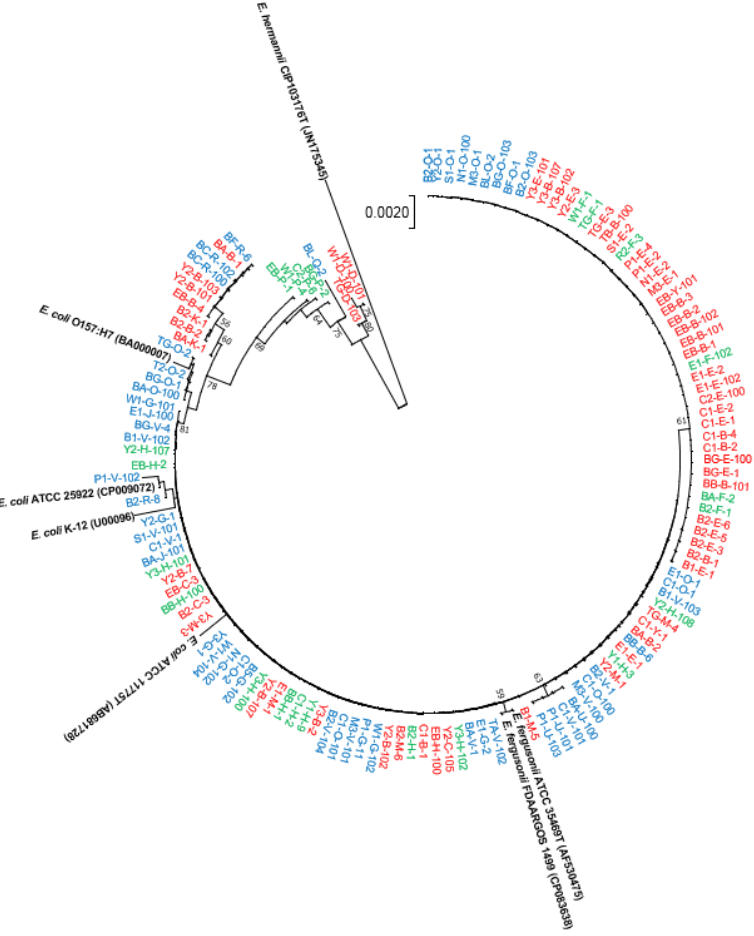
Figure 1. The neighbour-joining phylogenetic tree based on 16S rRNA gene sequences of isolated E. coli / E. fergusonii strains from patients with IBD or IC patients and healthy controls (HCs). The numbers at the nodes indicate the percentage of 1000 bootstrap replicates, and Escherichia hermannii CIP 103176 T was used an outgroup. The accession numbers of retrieved 16S rRNA gene sequences are given in parentheses. Strains names with colour codes (red = IBD; green = IC; and blue =